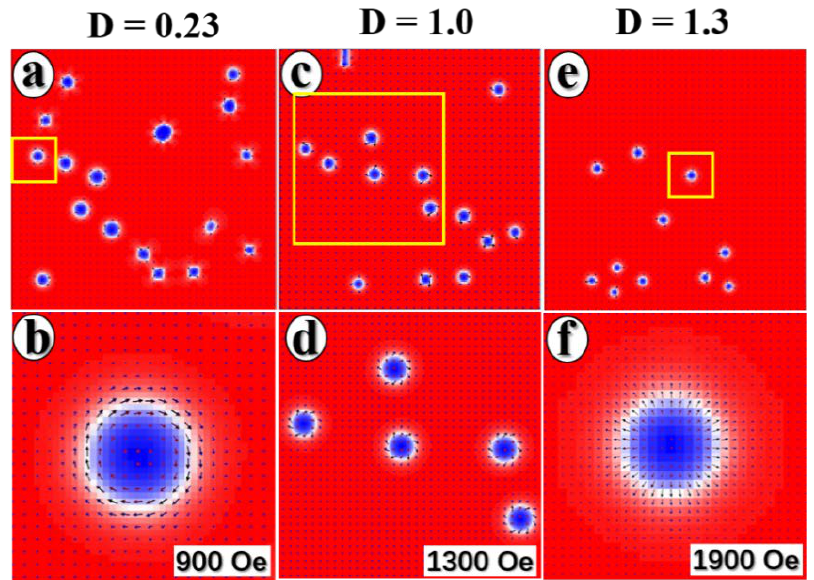
Figure 4. Micromagnetic simulated magnetic structure. ( a ) Bloch-type skyrmions generated at D = 0.23 mJ/m 2 , ( b ) is the enlargement of selected region. ( c ) Hybrid-type skyrmions are generated at D = 1 mJ/m 2 , ( d ) is the enlarged spin configuration of selected skyrmions. ( e ) Néel-type skyrmions generated at D = 1.3 mJ/m 2 , ( f ) represents the enlarged spin configuration of selected skyrmions.